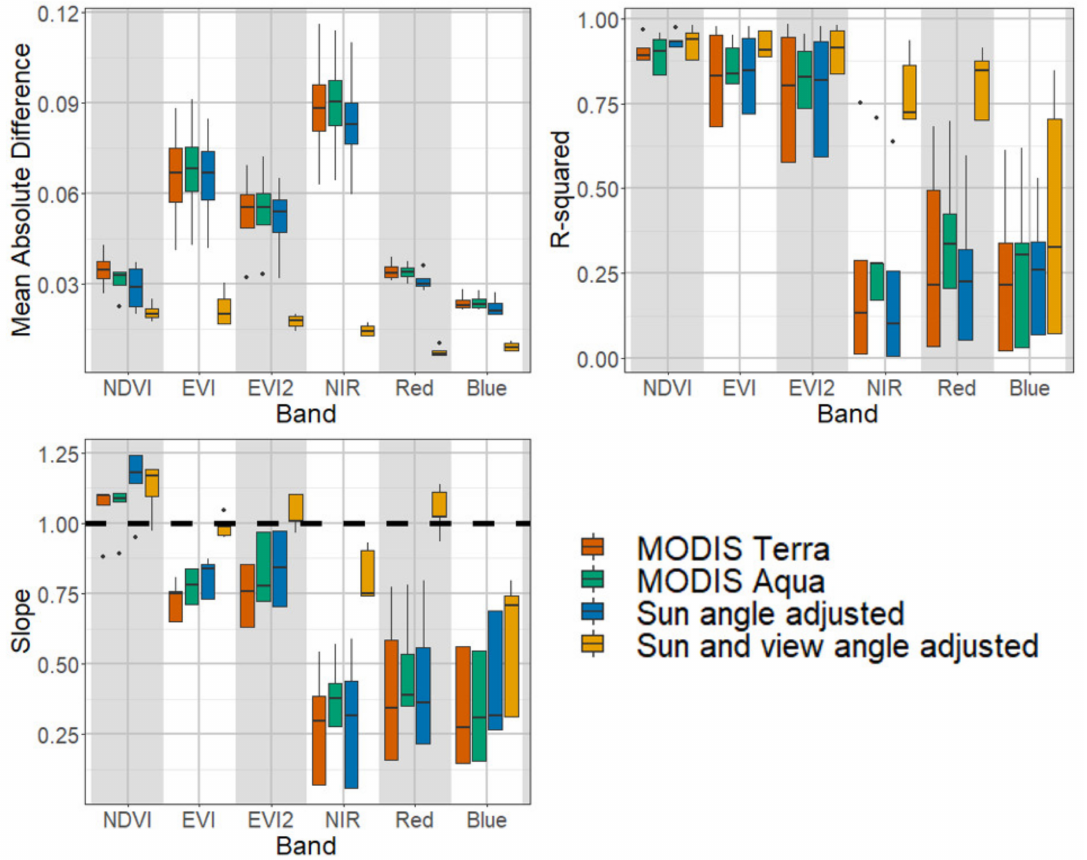
Figure 13. Global cross-site relationships (mean absolute di ff erence, R 2 , and slope) between daily composited AHI reflectances (red, NIR, blue) and VIs (NDVI, EVI, EVI2) with equivalent MODIS VI values using Terra and Aqua MODIS standard products, MODIS BRDF-adjusted values to solar noon / nadir view, and BRDF-adjusted values to solar noon and AHI fixed view zenith